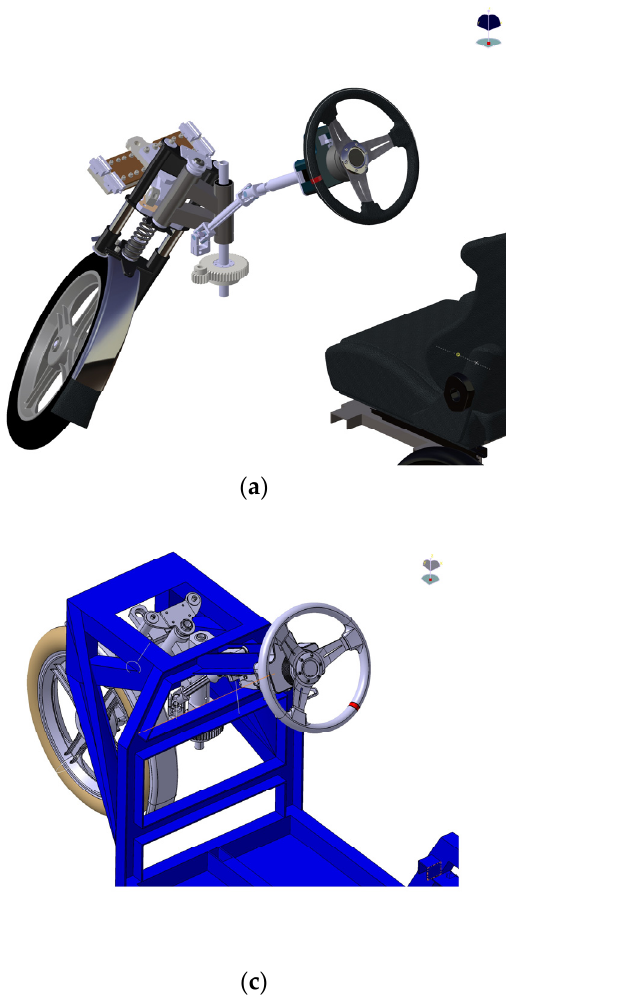
Figure 2. A 3D CAD model of the mechanism design: ( a ) Original design; ( b ) Design no. 1; ( c ) De- sign no. 2; ( d ) Design no. 3. no. 2; ( d ) Design no.